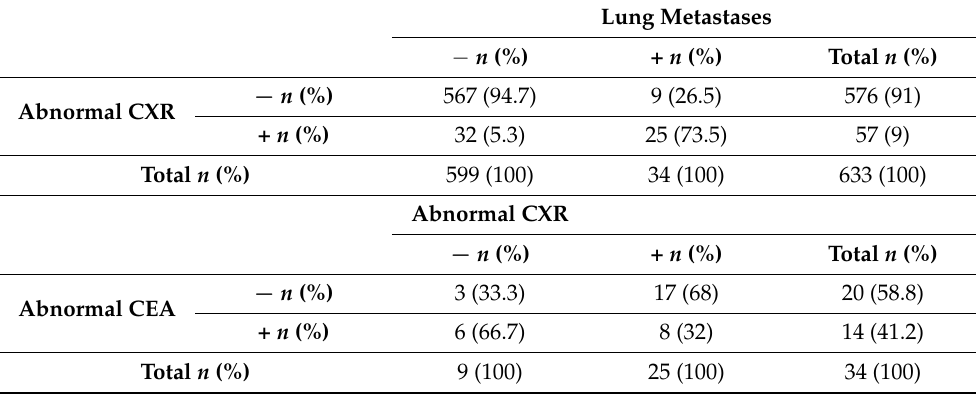
Table 2. Chest X-rays in all patients and chest X-rays and CEA levels in patients with lung